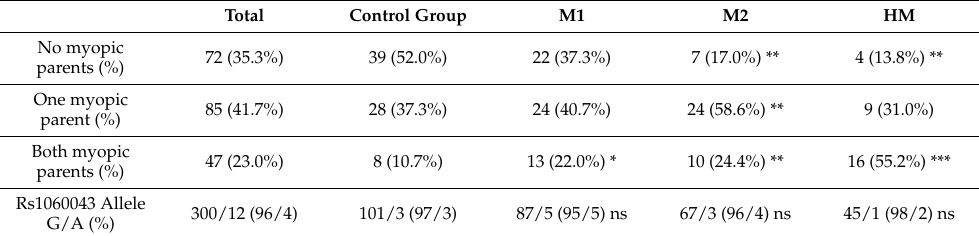
Table 3. Myopia hereditary factors and CUVAF genetic factors in the entire student population. Calculation of frequencies with respect to the control group using Fisher’s F